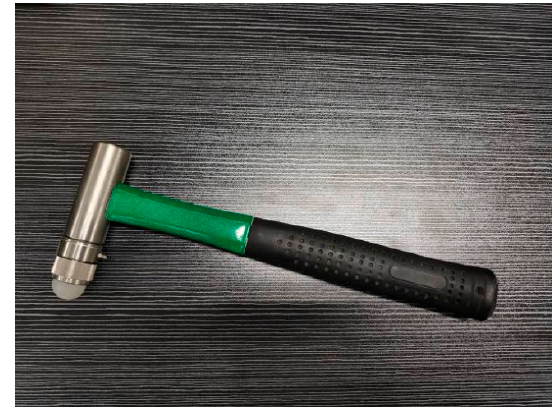
Figure 9. Force hammer.